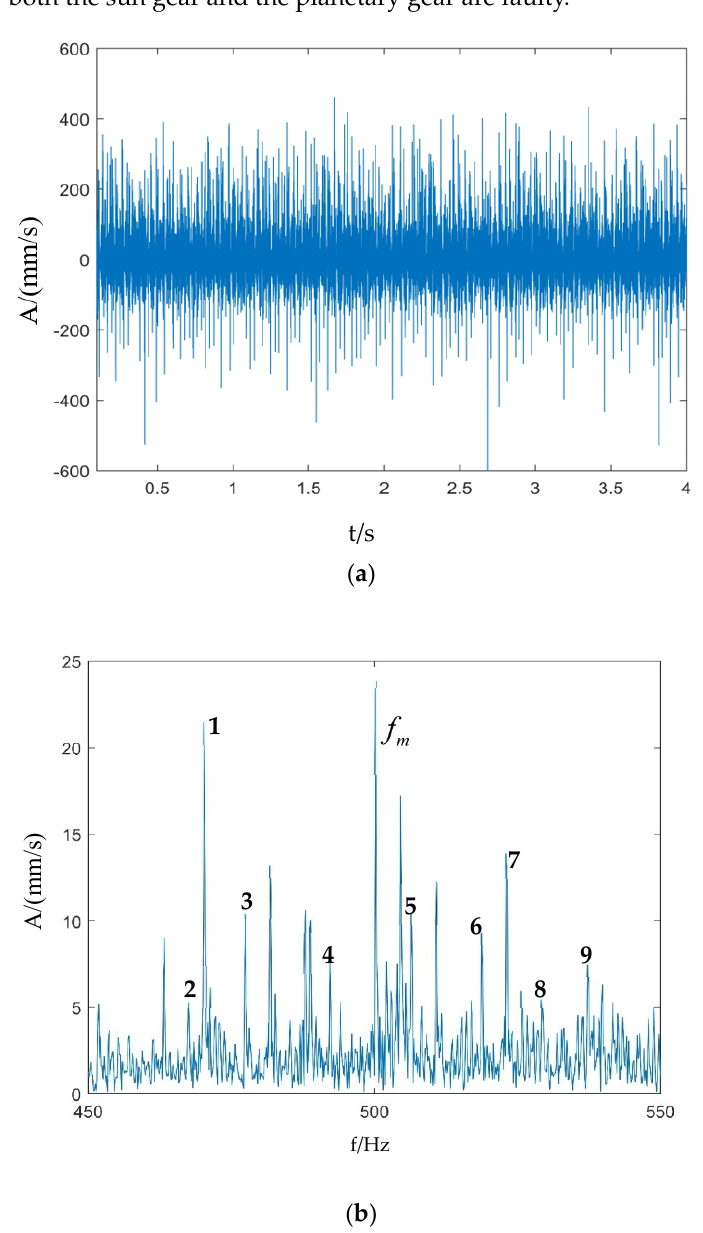
Figure 9. Simulated vibration signal of sun gear missing teeth and planetary gear missing teeth: ( a ) Time domain waveform; ( b ) Fourier spectrum.